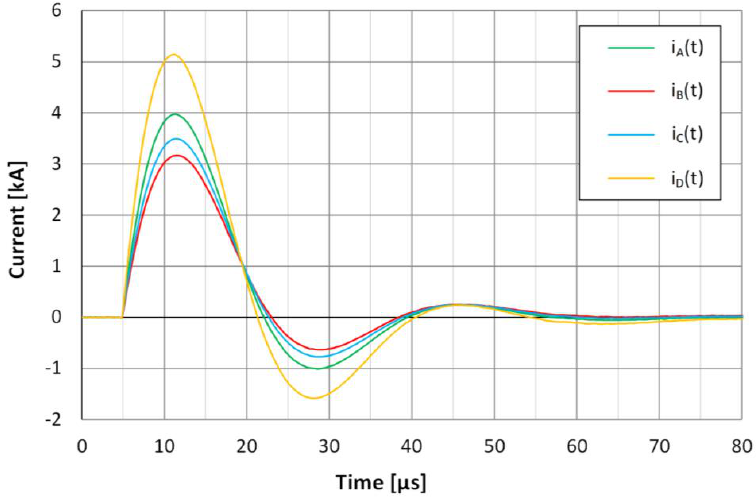
Figure 5. Current distribution in an aluminum calibration plate during the preliminary tests for the final solution of the test bench design.